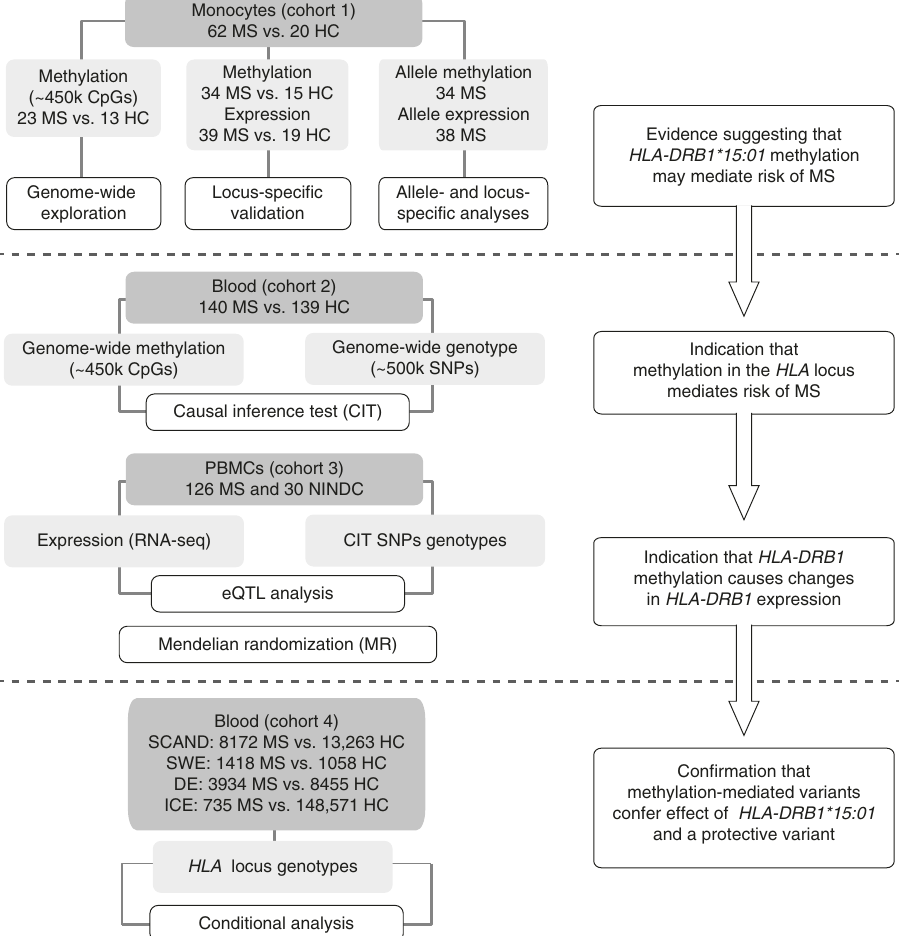
Fig. 1 Study design and work fl ow diagram. MS: multiple sclerosis, HC: healthy controls, SNP: single nucleotide polymorphism, CIT: causal inference test, eQTL: expression quantitative trait loci, NINDC: non-in fl ammatory neurological disease controls, SCAND: Scandinavia, SWE: Sweden, DE: Germany, ICE: